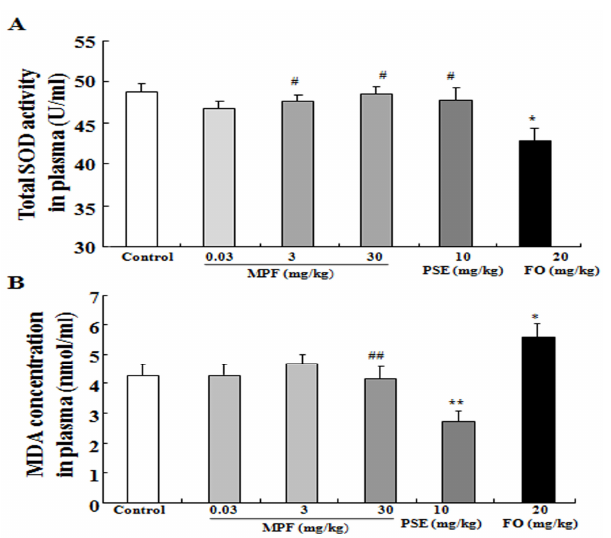
Figure 4. Effects of PSE, FO, and MPF on the SOD activity and MDA level of the plasma. Effects of